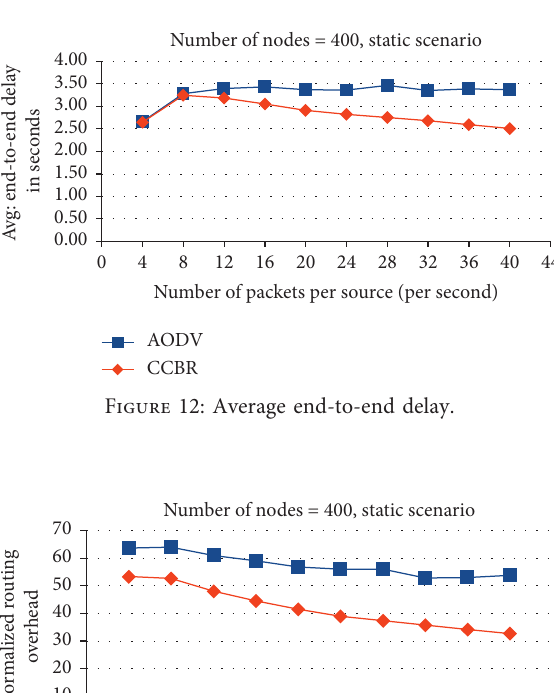
Figure 8: End-to-end delay.